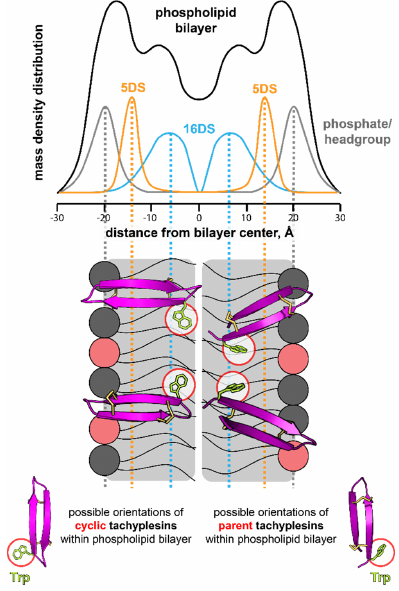
Figure 7. Schematic representation of the proposed orientations of tachyplesin peptides and cyclic analogues, when inserted into negatively-charged membranes based on the tryptophan fluorescence quenching, results with 5- and 16DS. The phospholipids in grey represent PC headgroups and the phospholipids in red represent PS headgroups. The peptides have a backbone length of approximately 25 Å (measured in PyMol) and are able to span across a lipid monolayer. Other orientations are possible. The distribution of the 5DS and 16DS quencher within a phospholipid bilayer was illustrated based on previous publications